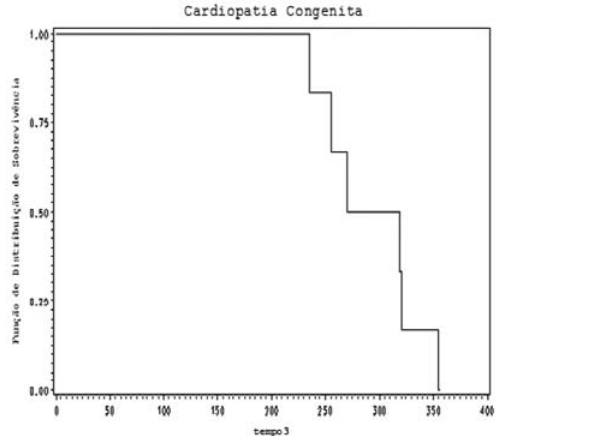
Fig. 6 - Sobrevivência por Tipo: Cardiopatia Congênita - tempo 3: T3 - Tempo da Presença do Doente na Sala de Operação